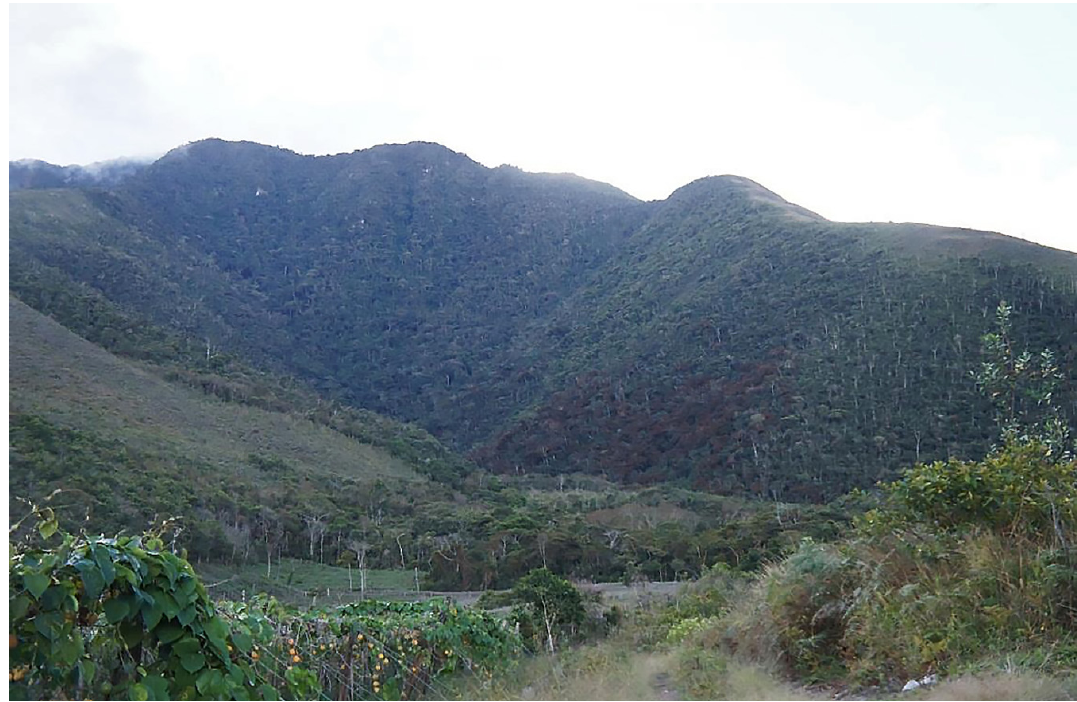
Figure 8. Type locality of Cercosaura pacha sp. nov, montane forest of Lanturachi, near Oxapampa, Department of Pasco, Peru. Photo: Consuelo Alarcón.